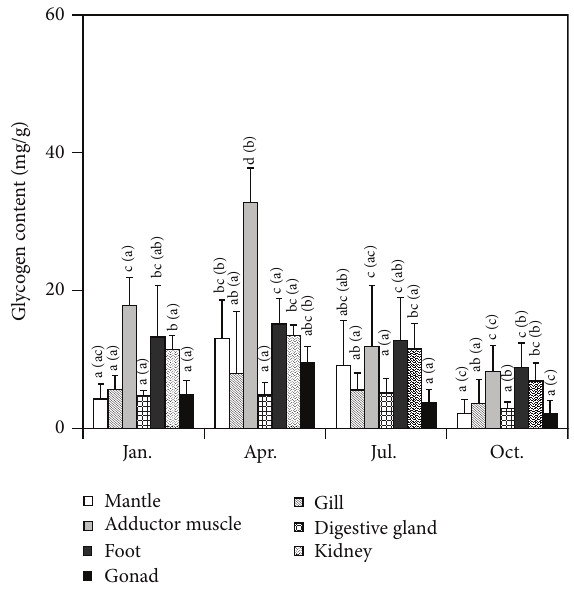
Figure 2: Seasonal changes in glycogen content in different tissues collectedfromthepenshell, Atrina lischkeana .Barsrepresentmeans and whiskers represent standard deviation. 3–6 samples (replicates) were used for the analysis of each organ. No common letters out of parentheses indicate significant differences of glycogen contents in different tissues on each month and no common letters in parentheses indicate significant differences of seasonal changes on each tissue ( 𝑃 < 0.05 ; Tukey-Kramer test).